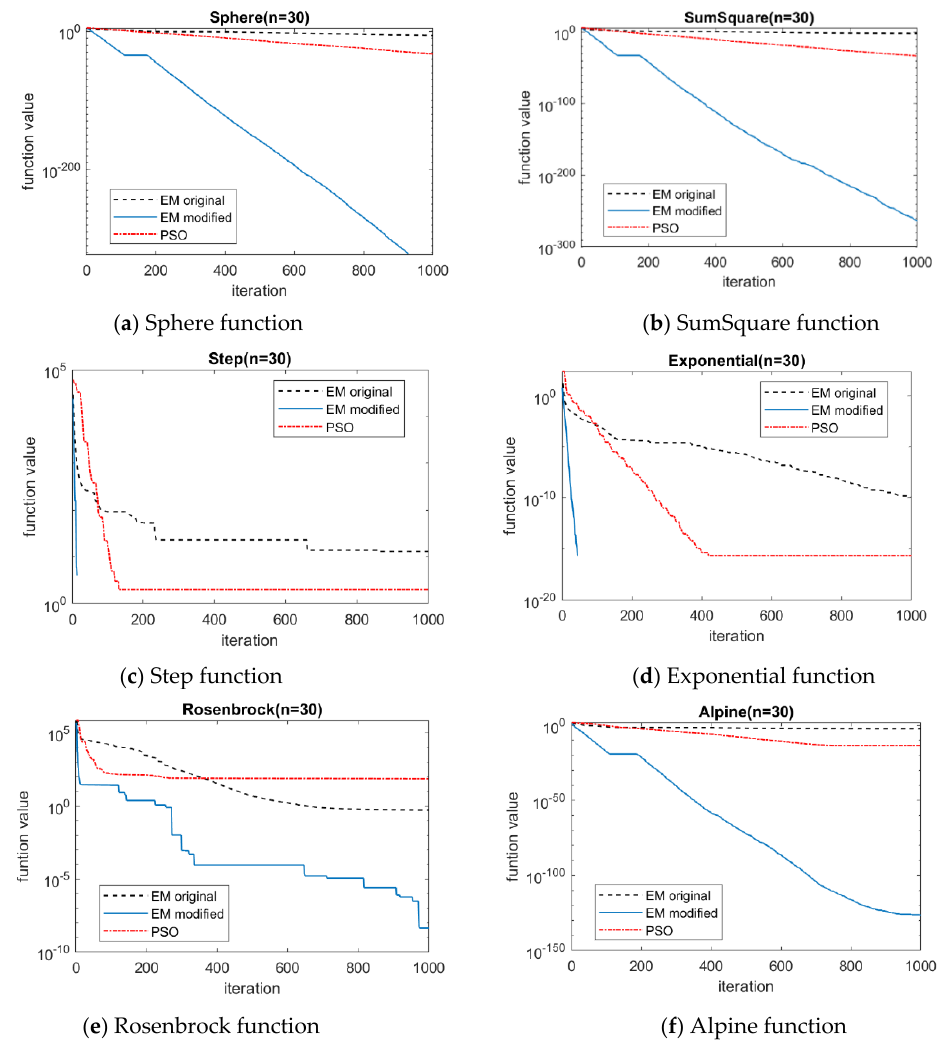
Figure7. Convergencelinesofsixbenchmarkfunctionswith30dimensions. ( a ): Sphere; ( b ):SumSquare; Figure 7. Convergence lines of six benchmark functions with 30 dimensions. ( a ): Sphere; ( b ):